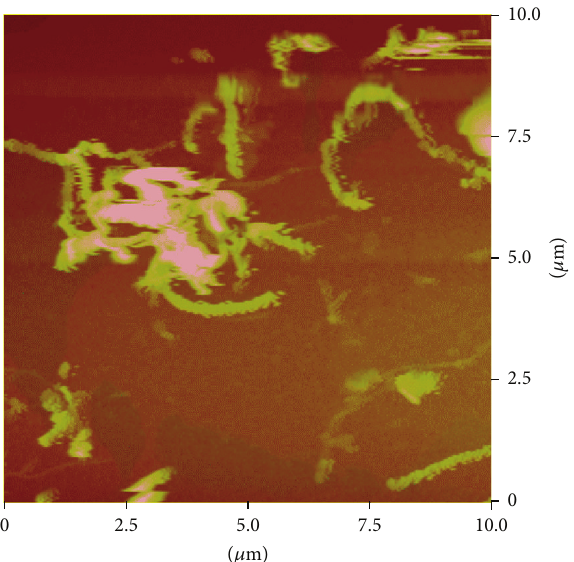
Figure 4: AFM image of the PABA/MWNTs composite film containing 7.5mg/mL MWNTs after electropolymerization for 5 cycles in 0.5 MH 2 SO 4 .